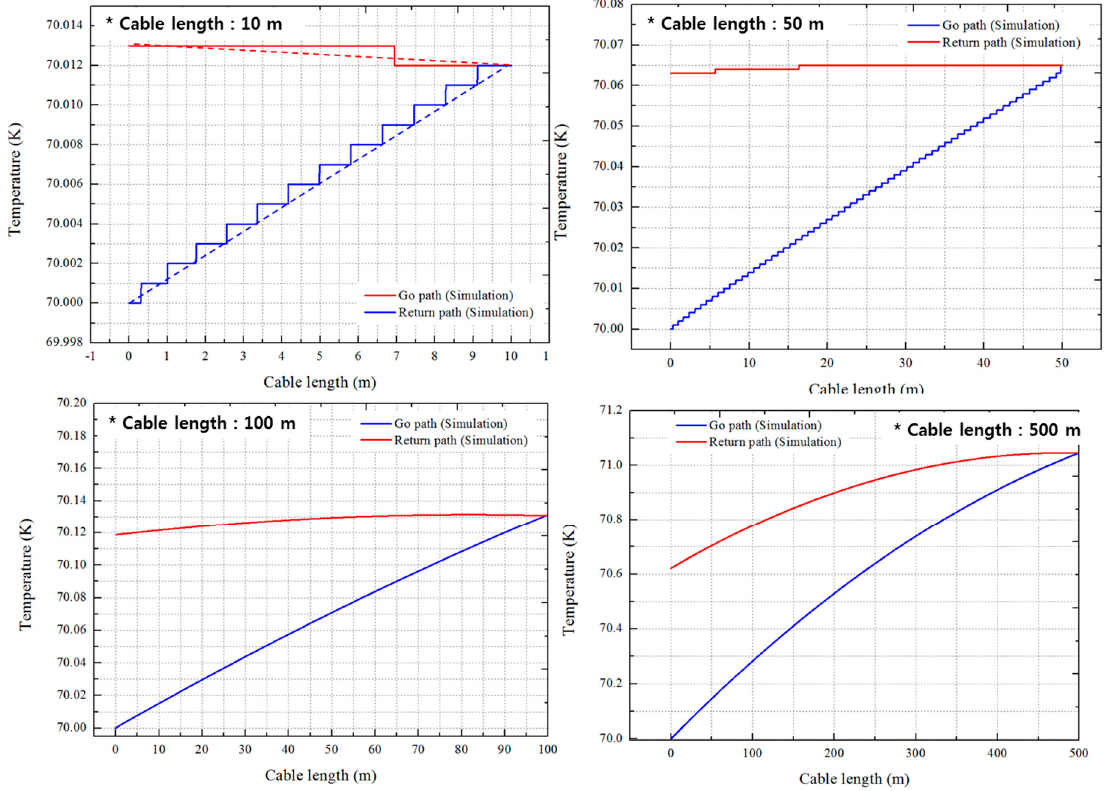
Figure 8. Results of temperature analysis according to cable length of Case.